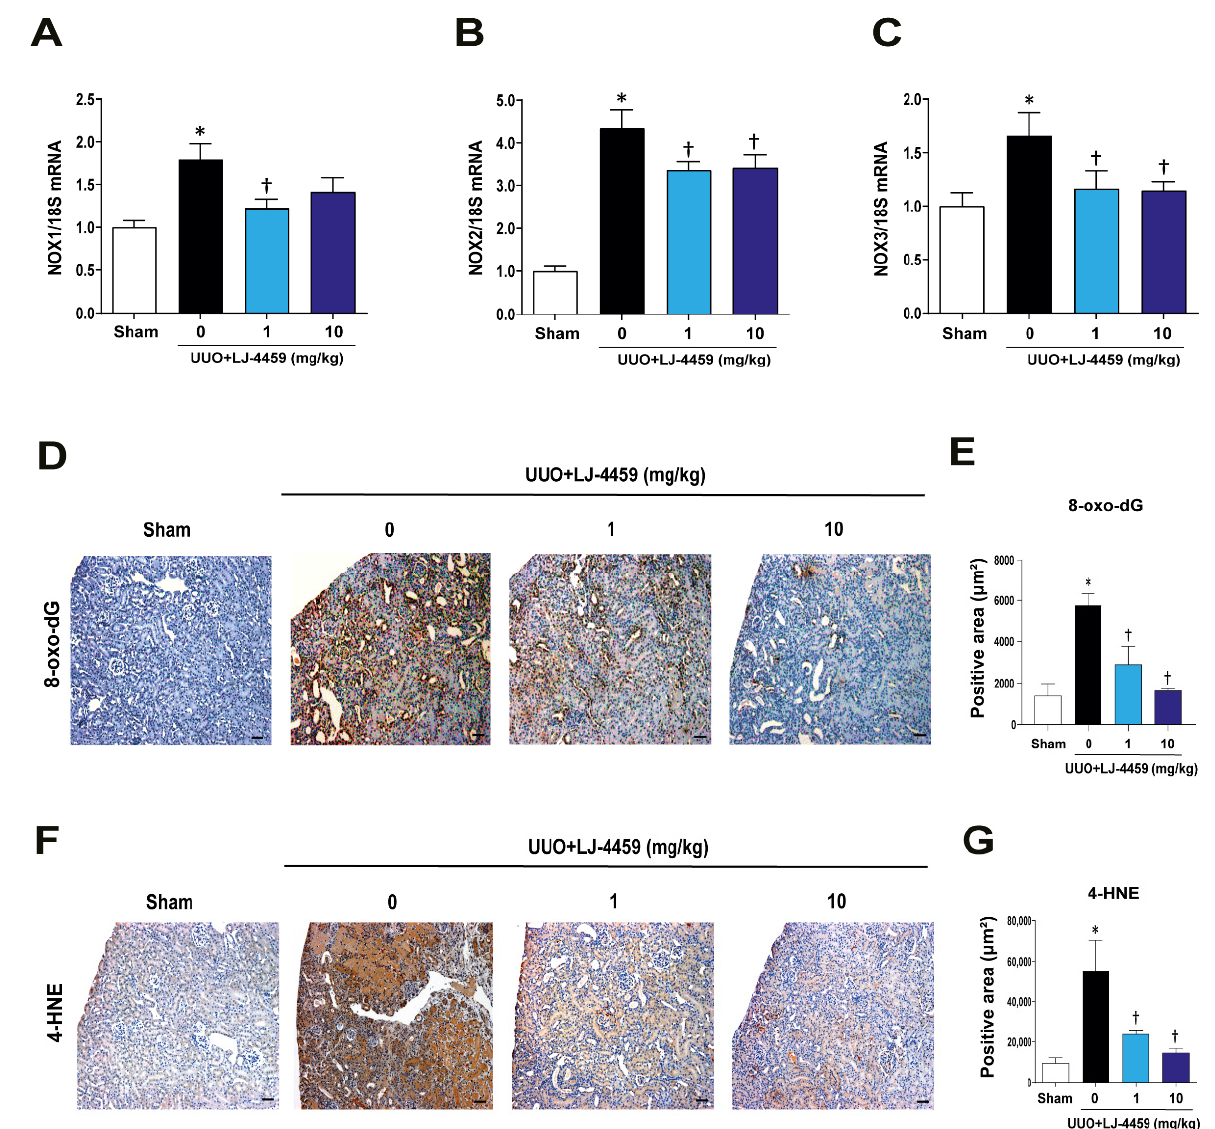
Figure 5. LJ-4459 decreases oxidative stress in UUO mice. ( A – C ) The mRNA levels of oxidative markers such as NOX1, NOX2, and NOX3 were measured by real time RT-PCR. The levels of mRNA were normalized with 18S. Paraffin-embedded kidney sections were stained with ( D , E ) 8-oxo-dG antibody (1:400; original magnification: 100 × ; scale bar: 50 µ m) and ( F , G ) anti-4HNE antibody (1:200; original magnification: 100 × ; scale bar: 50 µ m). Data are presented as mean ± SE of 7–8 mice. * p < 0.05 vs. sham mice, † p < 0.05 vs. UUO mice.